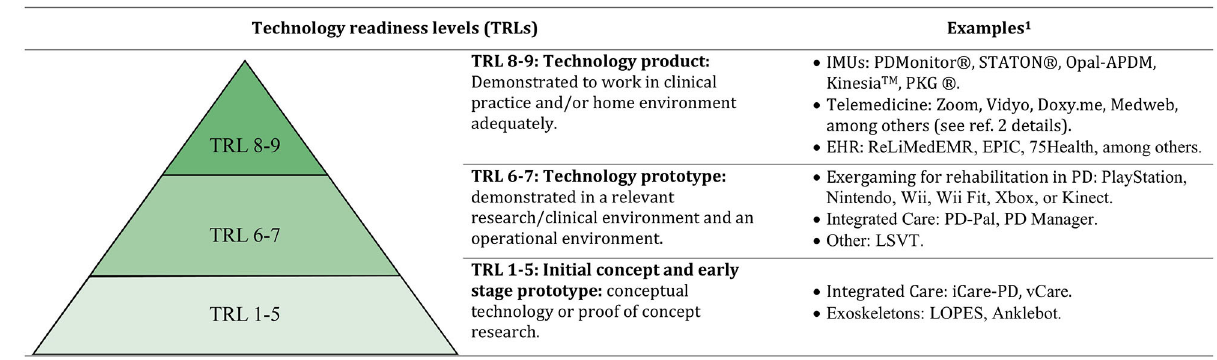
TABLE 1 | Currently available systems with advance regulatory status for the objective quantification of movement in Parkinson’s disease patients. System